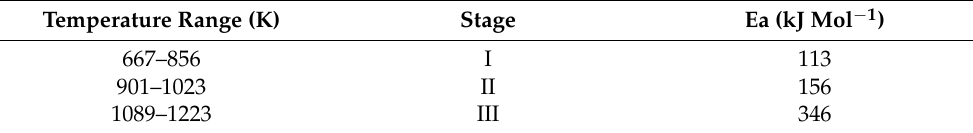
Figure 7. Arrhenius diagram of the pentlandite-bearing ore oxidation process. Table 5. Calculated values of the activation energies.